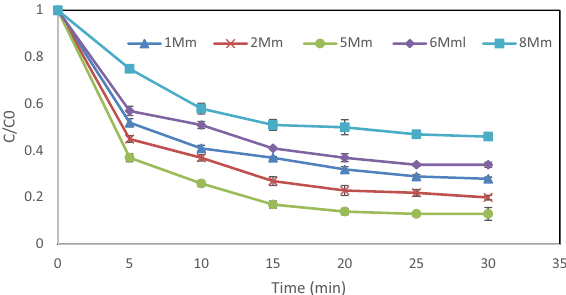
Figure 6. Impact of H 2 O 2 dosage on the removal efficiency of DEX under the following conditions: pH = 3, DEX concentration = 20 mg/L and MgO dosage = 0.05 g/L.